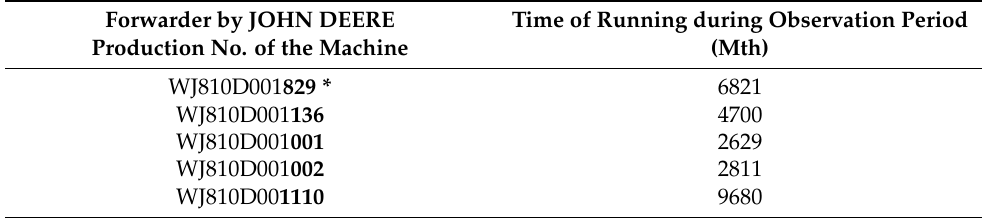
Table 1. Observed and assessed forest forwarders. * Bold format shows the differences among the